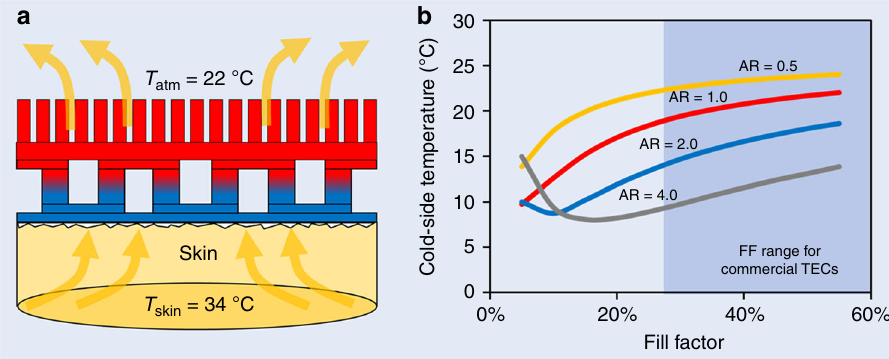
Fig. 4 Optimal module design for wearable TECs. a Schematic illustrating the wearable TEC placed on human skin. High-thermal resistivity of skin and ambient air along with the contact resistance at skin – TEC interface provide a huge thermally resistive environment to the wearable TEC. Arrows illustrate heat fl ow from human skin to the ambient via TEC and heat sink. b Cold-side temperature of the wearable TECs at different FF and AR. The optimal FF for wearable TEC should be less than 15% and AR should be in the range of 1 –